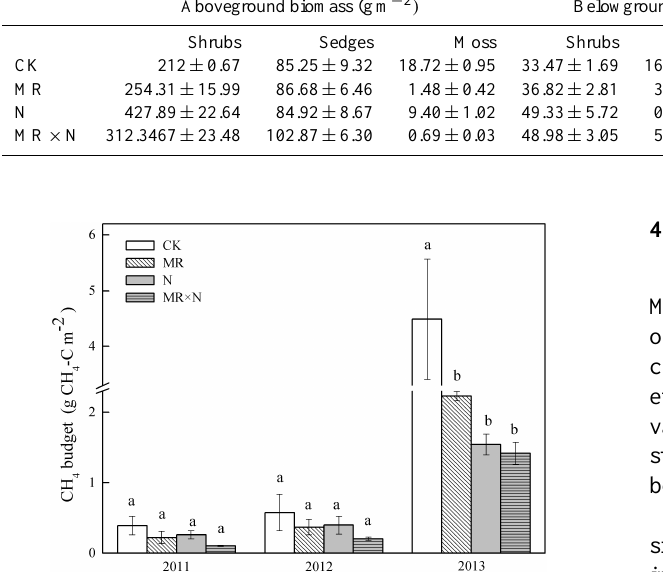
Figure 3. Annual CH 4 budget in 2011, 2012 and 2013. Error bars represent standard errors ( n = 3). CK, control; MR, moss removal; N, N addition; MR × N, moss removal plus N addition. Different lowercase letters indicate significant differences among treatments ( p < 0 .